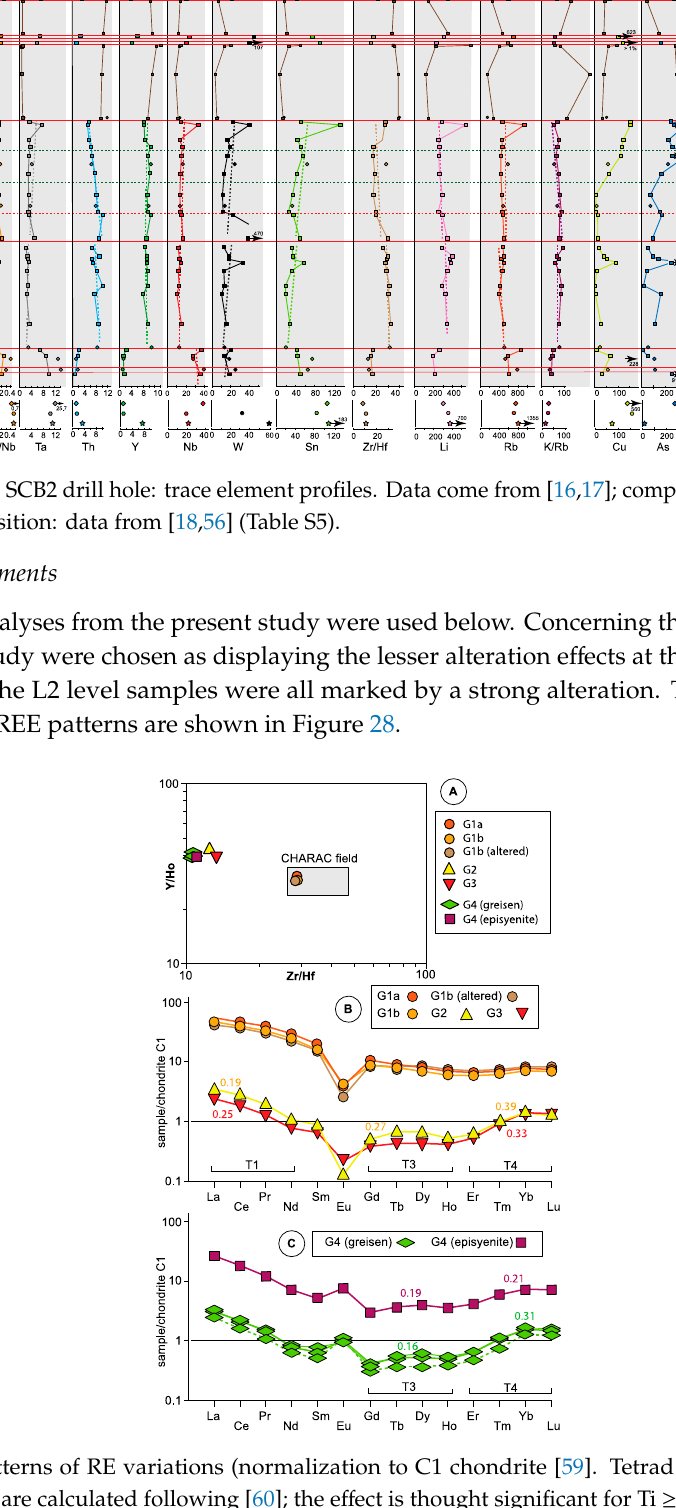
Figure 28. Patterns of RE variations (normalization to C1 chondrite [59]. Tetrad effect parameters Ti (i = I, II, III) are calculated following [60]; the effect is thought significant for Ti ≥ 0.2.